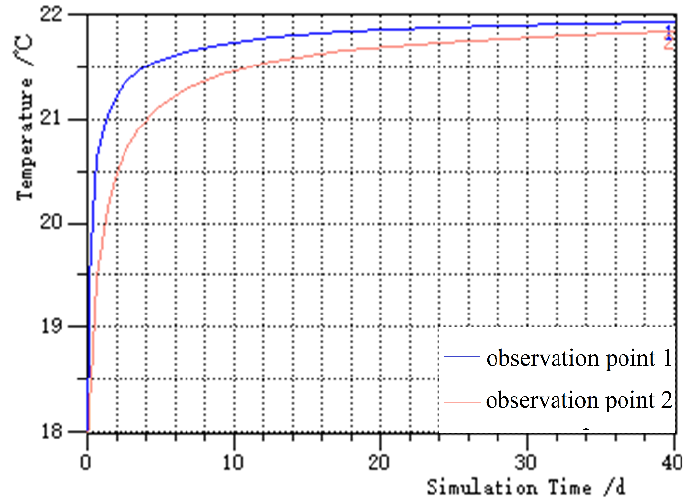
Figure 8. The temperature variation process of virtual observation points. According to Figure 8, the groundwater temperature at a certain distance from the river canal boundary varies asymptotically with time. Based on Equation (26), the excess temperature values T b ( x , t ) at x = 0.5 m and 1.0 m are calculated, and the sum of them and the initial temperature of the aquifer (18 ◦ C) constitute the analytic values of the corresponding aquifer temperature. Tables 2 and 3, and Figure 9, compare the outcomes of the analytical and numerical simulations, respectively. Table 2. Comparison of analytical and numerical results of virtual observation point 1 ( x = 0.5 m). Analytical Time/d Value/ ◦ C